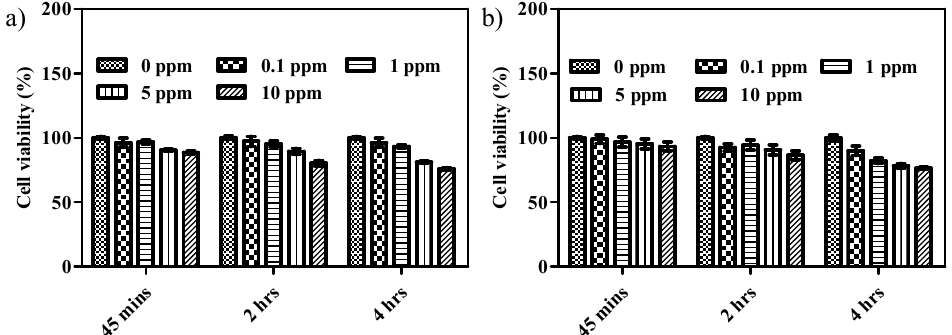
Figure 6. MTT assays of SV-HUC-1 cells cotreated with ( a ) Au@TNA@MB and ( b ) FA-conjugated Au@TNA@MB NPs for 0.75–4 h plus 650 nm light (125 mW/cm 2 ), followed by another 24 h of